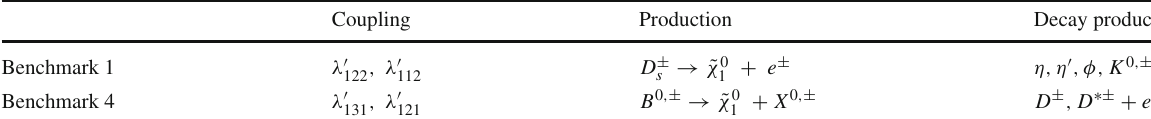
Table 1 Summary of two of the five benchmark models considered in Ref. [107]